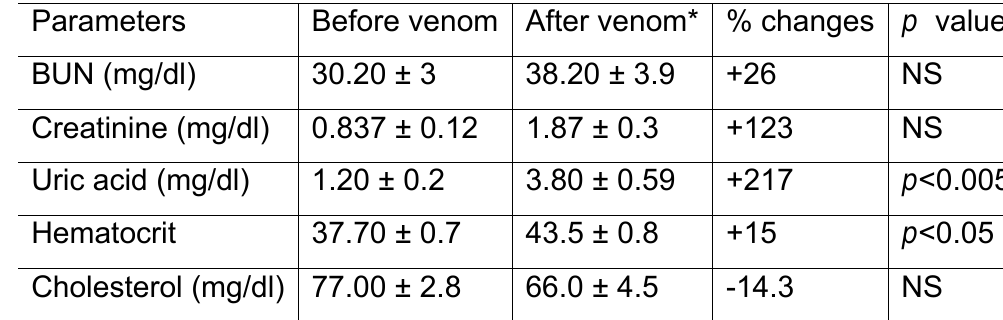
Table 2: Effects of O. doriae venom on rabbits serum uric acid, BUN, creatinine, hematocrit, and cholesterol (mean ±